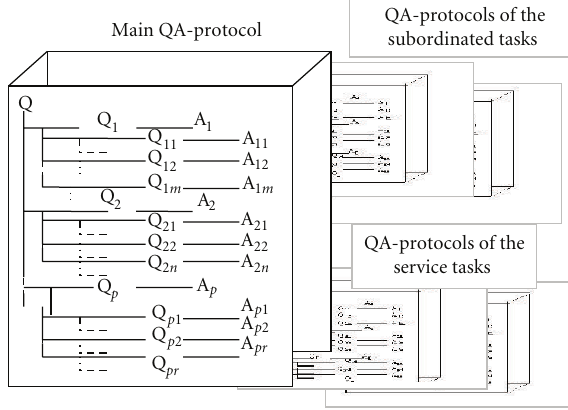
Figure 4: System of